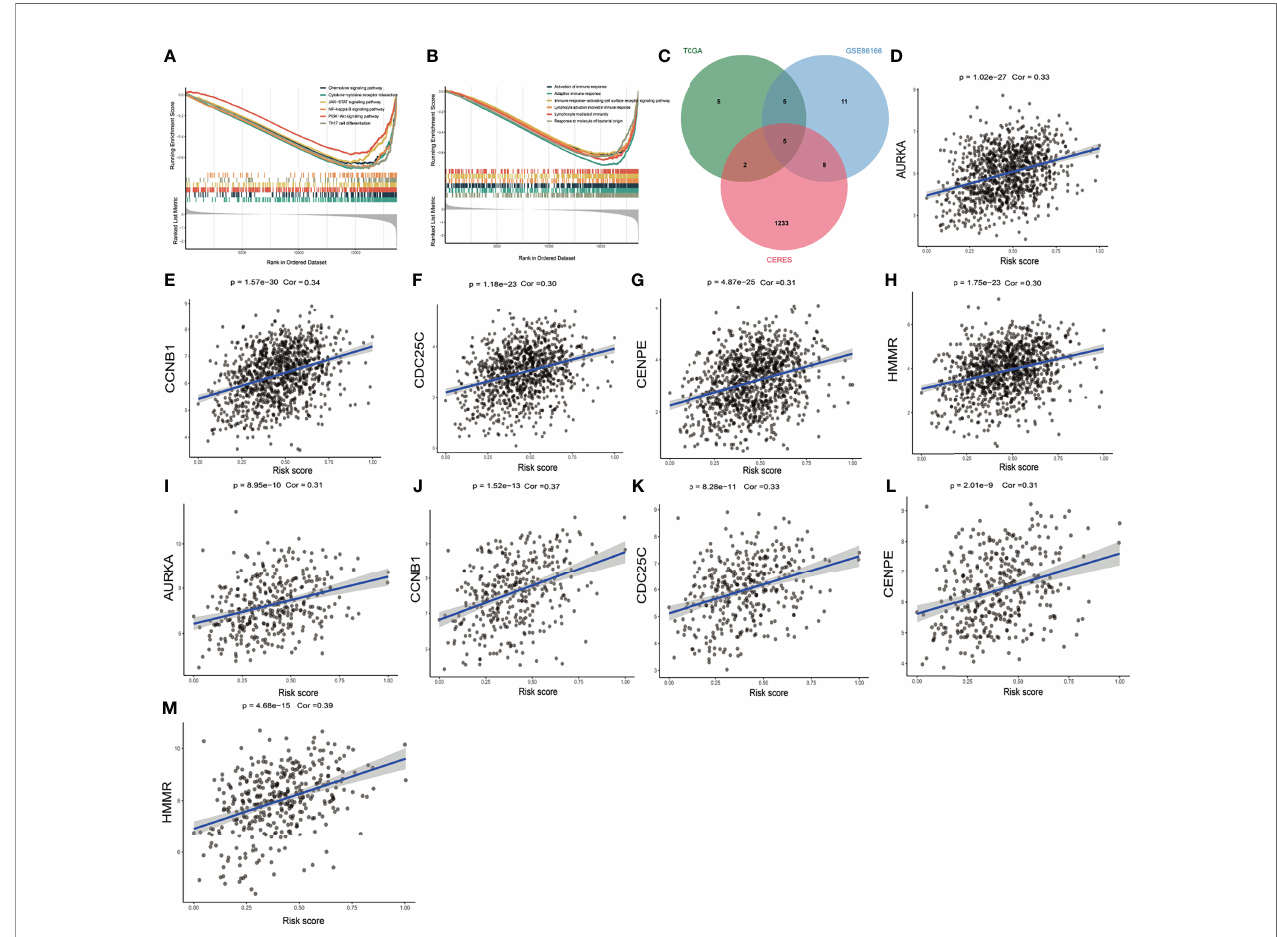
FIGURE 3 | Identi fi cation of risk score-related biological processes and drug targets. (A) The enriched KEGG gene sets. (B) The enriched biological process gene sets. (C) Venn diagram of three datasets. (D – H) The relationship between gene expression and risk score of AURKA, CCNB1, CDC25C, CENPE, and HMMR genes in TCGA dataset. (I – M) The relationship between gene expression and risk score of AURKA, CCNB1, CDC25C, CENPE, and HMMR genes in GSE86166 dataset.